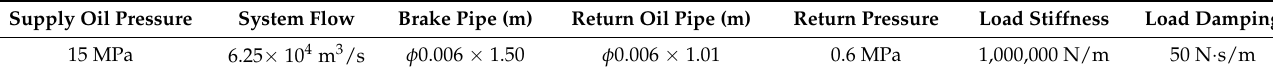
Table 4. Parameters of the experimental platform.